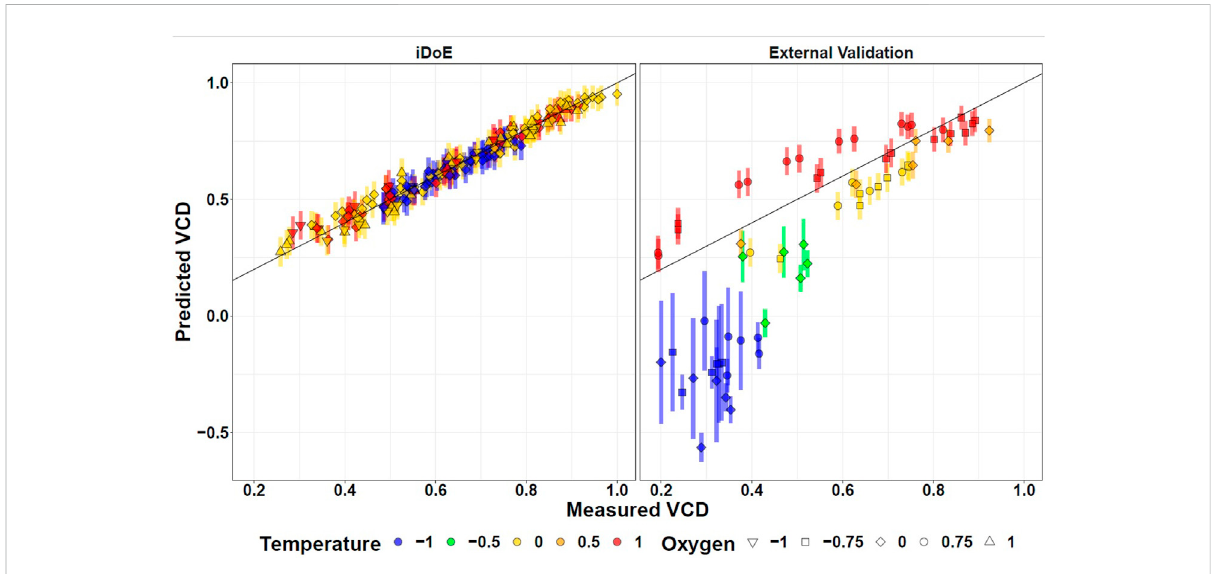
FIGURE 4 Fitting of OLS Model Predictions for VCD Based on iDoE Data to Internal iDoE Data and External Validation Data. Scatterplots visualizing the accuracy of model predictions for iDoE data (left) and external cDoE data (right). The error bars represent the 95% prediction